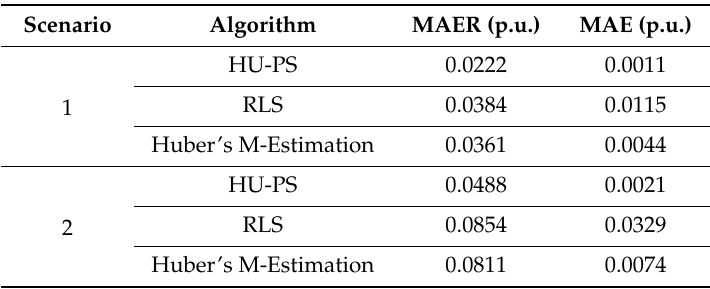
Table 2. Errors of TEPs estimation in case